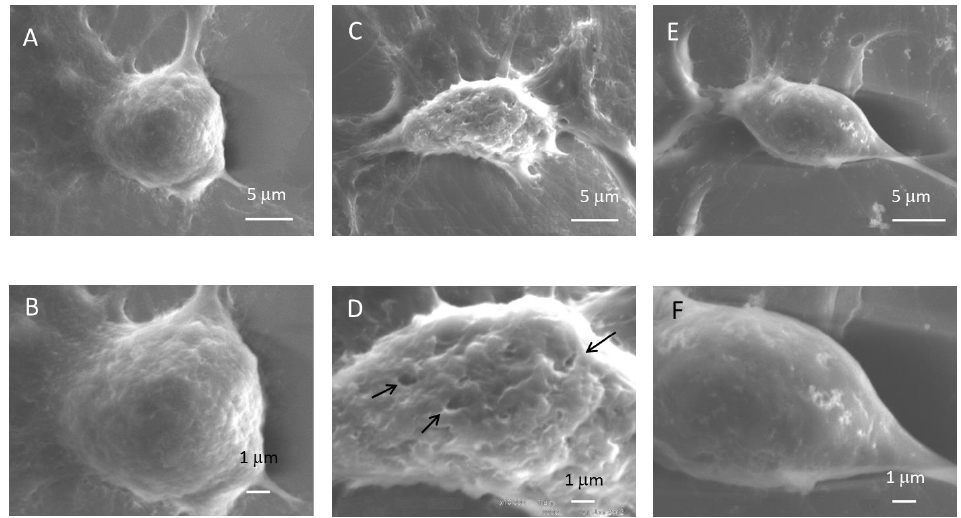
Figure 5. Scanning electron microscopy of oral SCC cells incubated with HSV-1 and treated with ultrasound. SAS cells grown on cover glass were processed for scanning electron microscopy ( A , B ) or exposed to ultrasound in the presence of microbubbles at room temperature ( C , D ); the cells were exposed to ultrasound and then incubated for 30 min at 37 °C prior to be scanned by electron microscopy ( E , F ). Arrows indicate depressions on the cell surface.